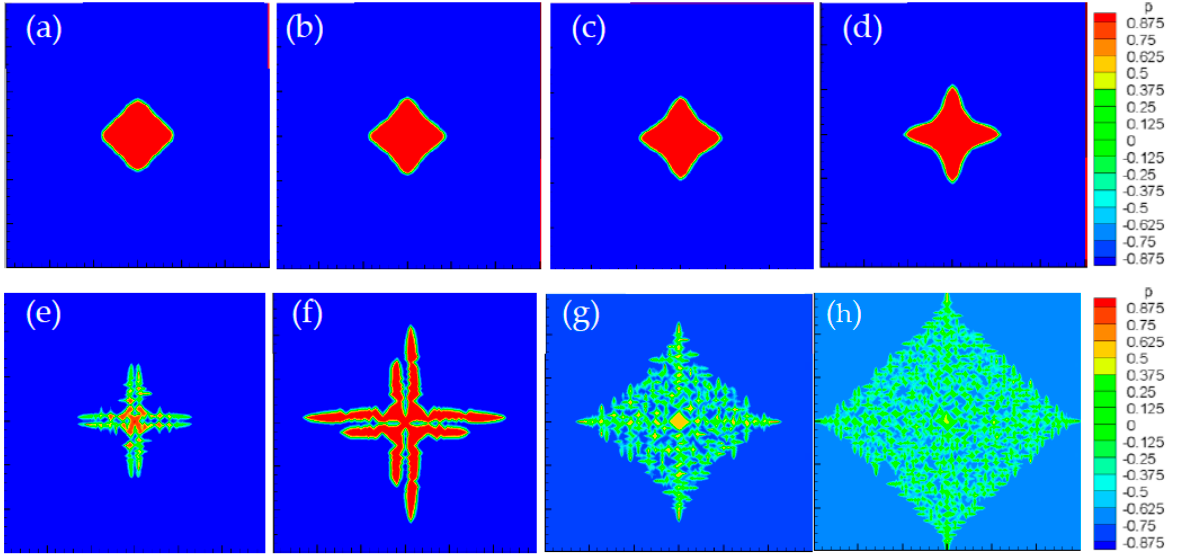
Figure 6. ∆ = − 0.45, t = 30,000 ∆ t, ( a ) γ = 0.03; ( b ) γ = 0.04; ( c ) γ = 0.05; ( d ) γ = 0.06; ∆ = − 0.45, t = 9000 ∆ t, ( e ) γ = 0.07; ( f ) γ = 0.08; ( g ) γ = 0.09; ( h ) γ = 0.1. Crystal phase field morphology.